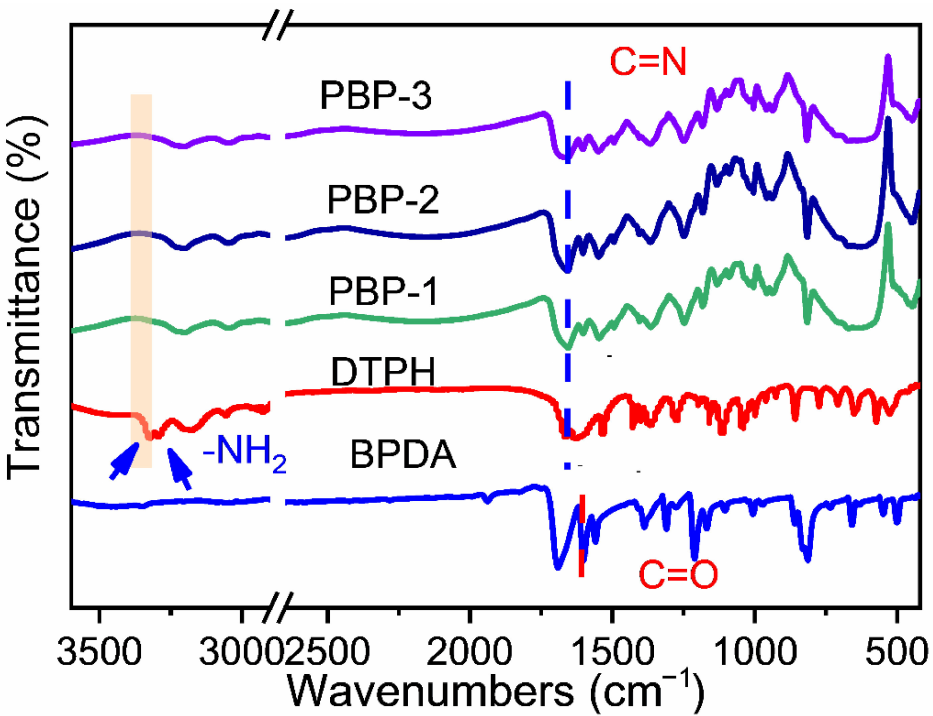
Figure 4. FT-IR spectra of BPDA, DTPH, and the resultant dynamic covalent materials PBP-X (X = 1, 2, 3).